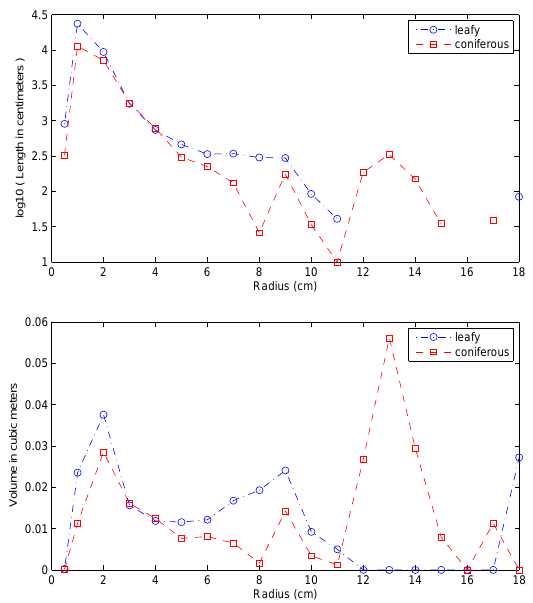
Figure 10: Distributions of branch length (above) and volume (below) as functions of branch